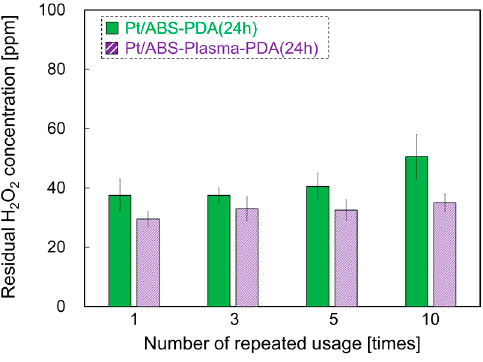
Figure 8. Catalytic durability of Pt / ABS-PDA(24h) samples with or without plasma treatment before PDA coating: the relationship between the number of usage cycles and the residual H 2 O 2 concentration.